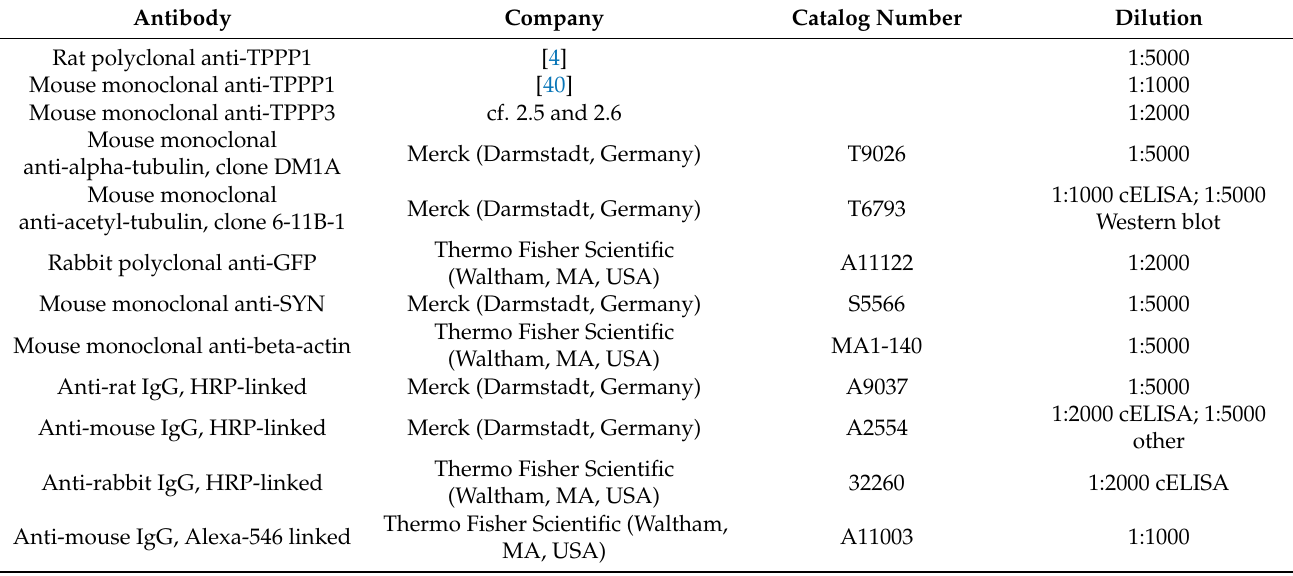
Table 1. Antibodies used for the